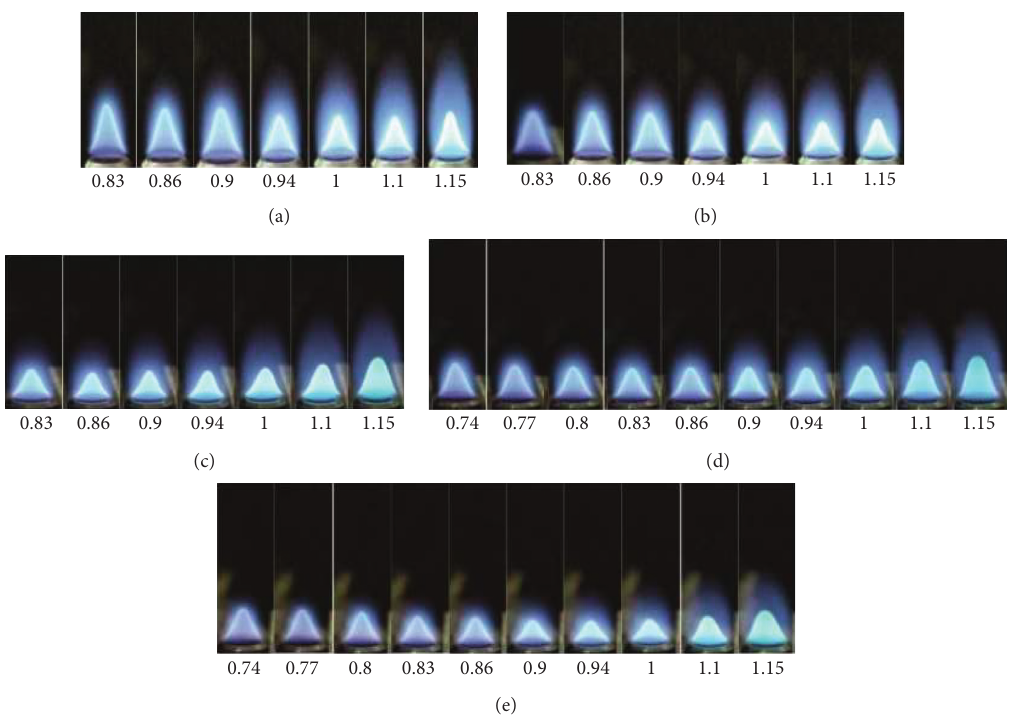
Figure 4: Stability and shape of the flame of coconut oil at equivalence ratio: (a) without magnet; (b) magnet S-S; (c) magnet N-N; (d) magnet S-N; (e) magnet